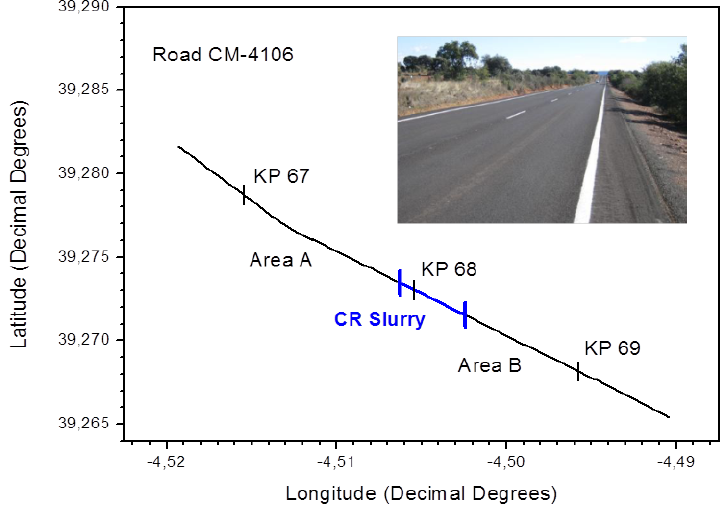
Figure 1. Location (GPS coordinates) of the test section at the road CM-4106 (Spain) with the different road surfaces